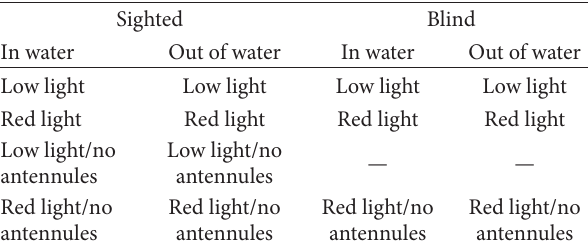
Table 2: Social interaction conditions for both species of crayfish. Social interactions were observed both in and out of the water for sighted and blind crayfish. Assessment of different sensory modalities impact on intrinsic behavior was examined through methodical removal of one or many sensory cues.